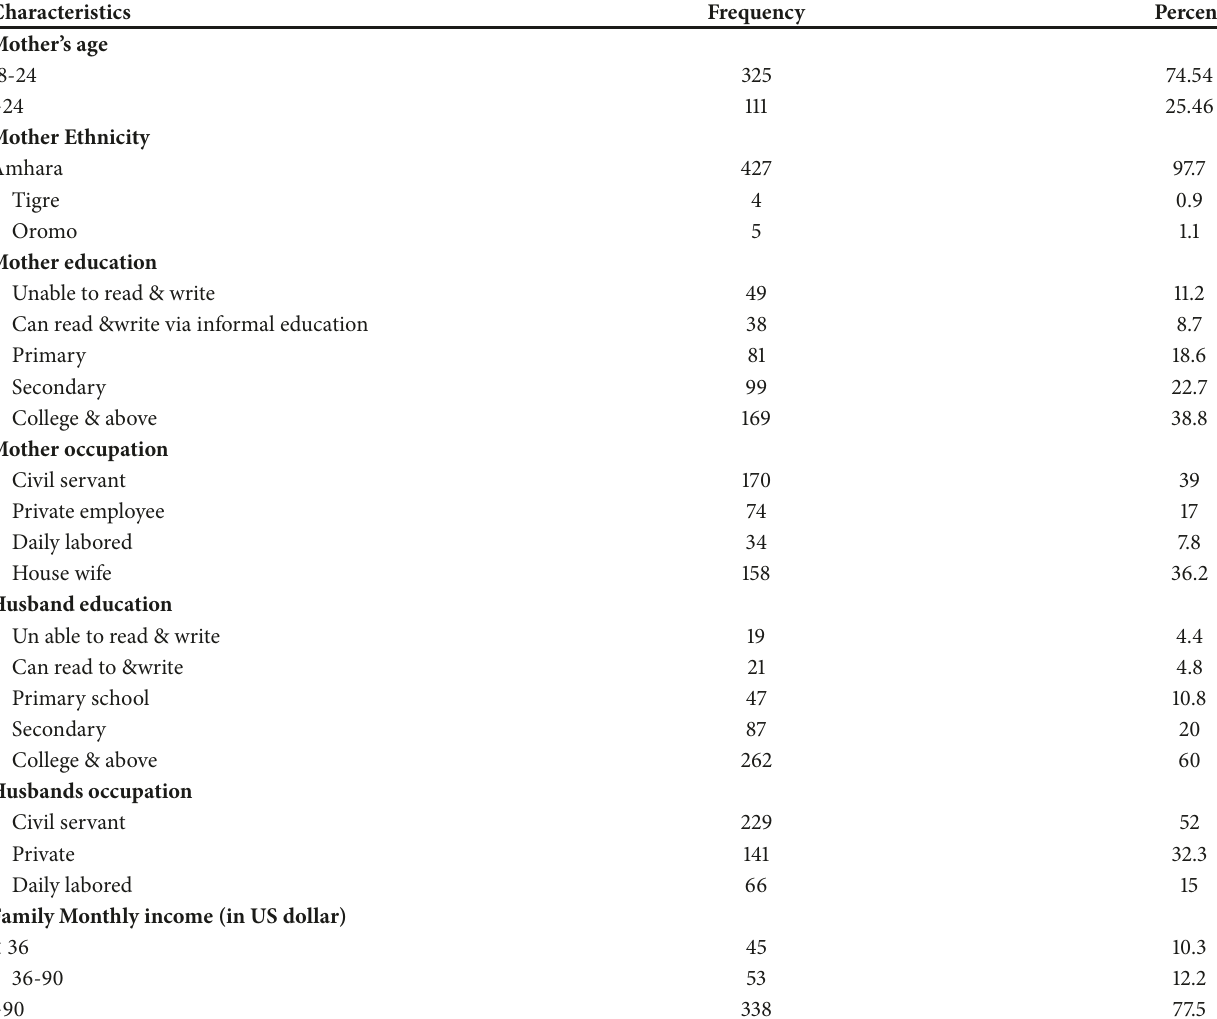
Table 1: Socio demographic related characteristics of pregnant women in Debre Markos town, 2017